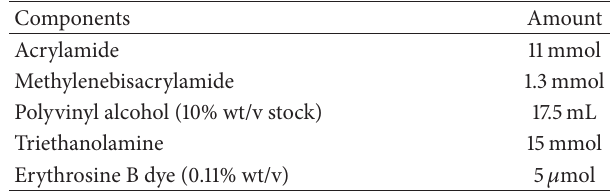
Table 1: Concentrations of the photopolymer composition.